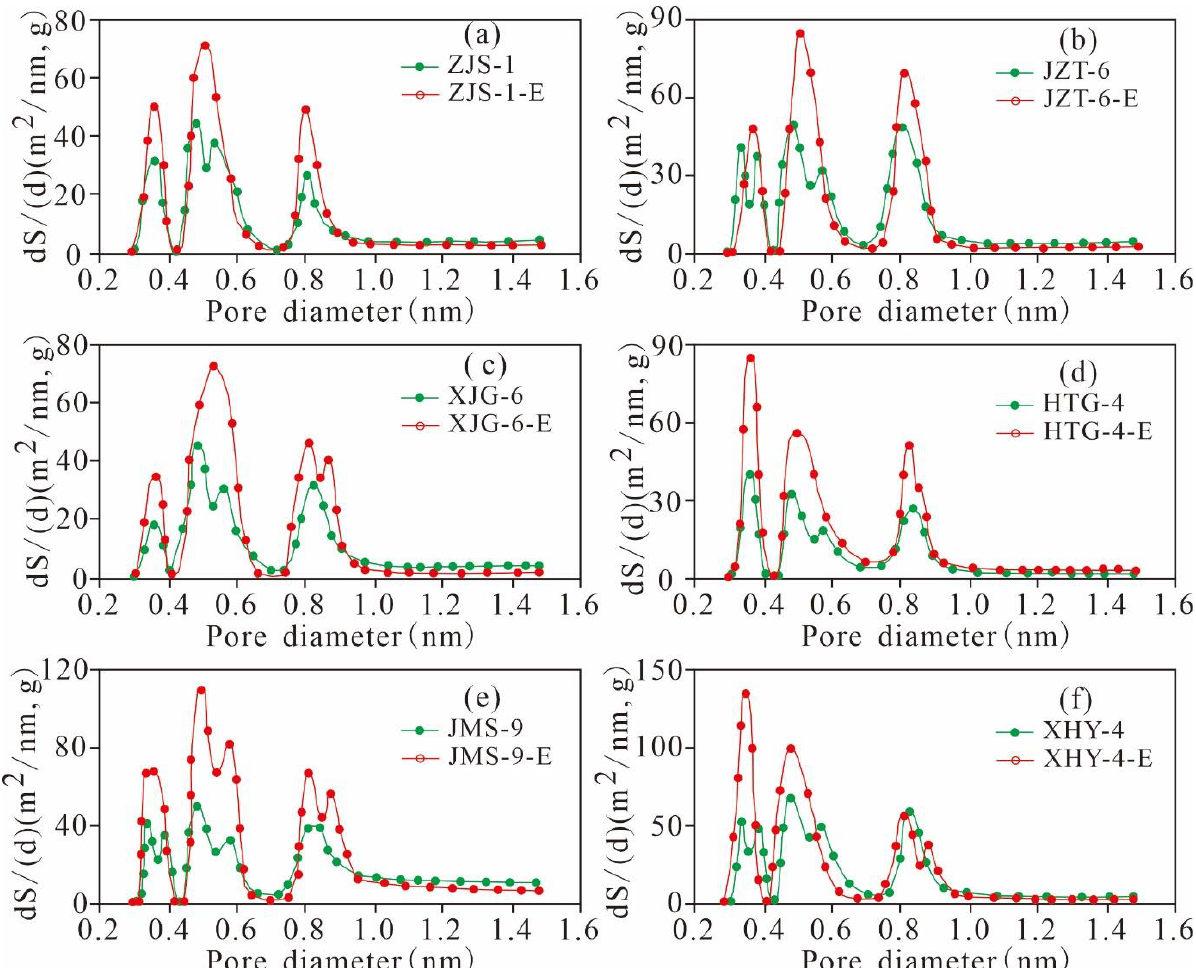
Figure 20. Micropore SA of the original shale and its corresponding extracted sample varies with pore size (( a ), ZJS-3; ( b ), JZT-6; ( c ), XJG-6; ( d ), HTG-4; ( e ), JMS-9; ( f ), XHY-4).